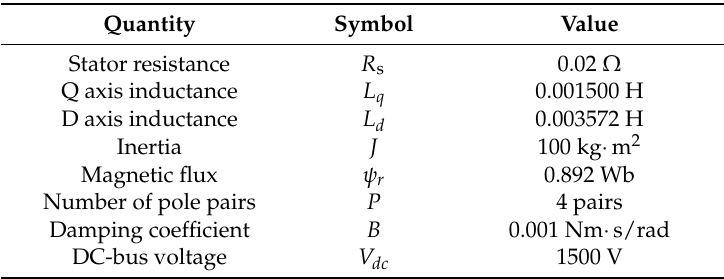
Table 2. Interior PMSM parameters.